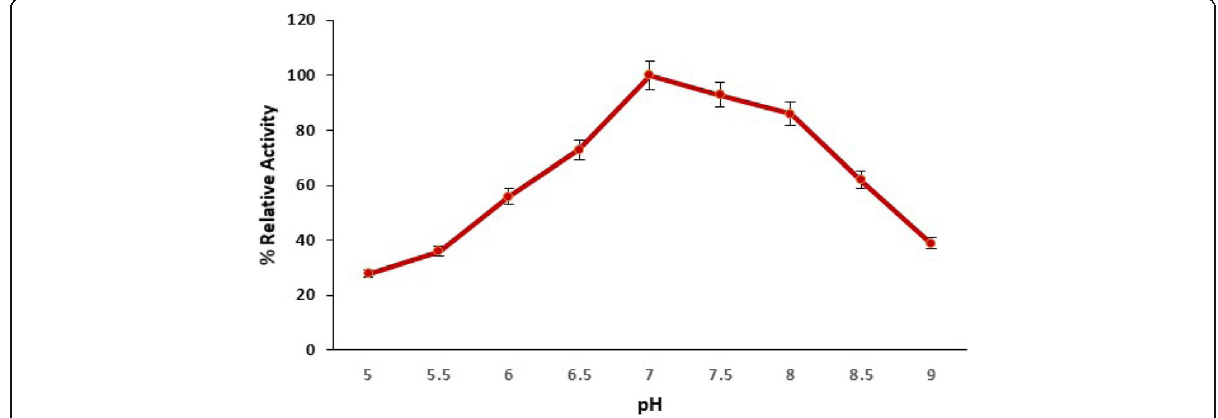
Fig. 5 The influence of pH on pectinase production by B. licheniformis KIBGE-IB3 using date fruit wastes as substrate (means ± S.E., n =